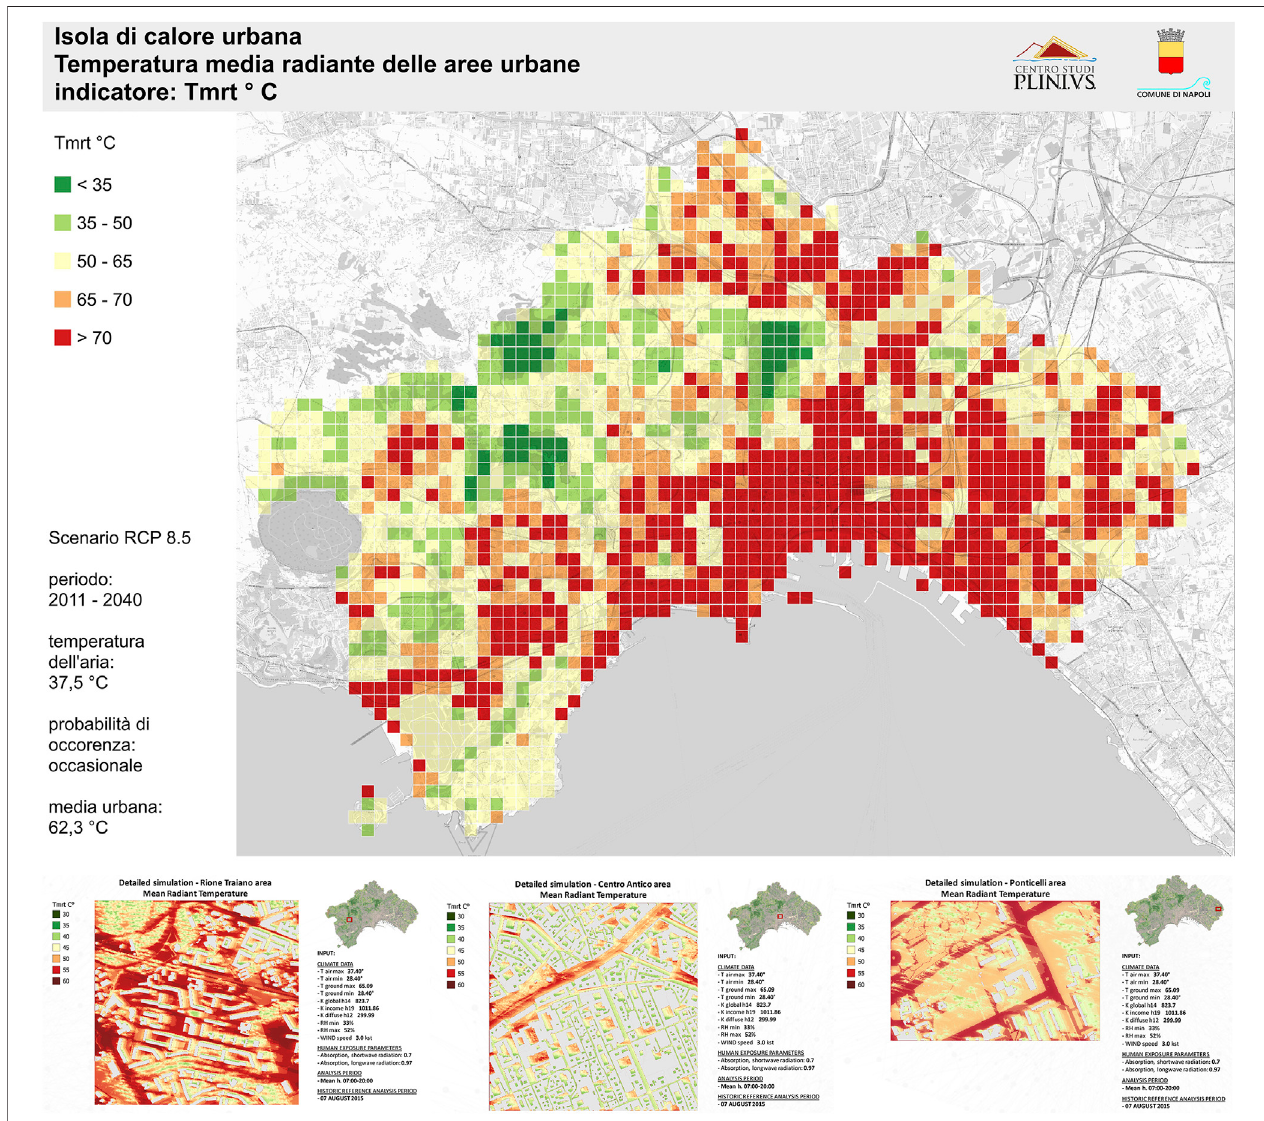
FIGURE 4 | Example of detailed analyses of heat wave hazard on sample cells carried out through SOLWEIG model (bottom) . Tmrt values correspond to an “ occasional ” event in the period 2011 – 2040, RCP